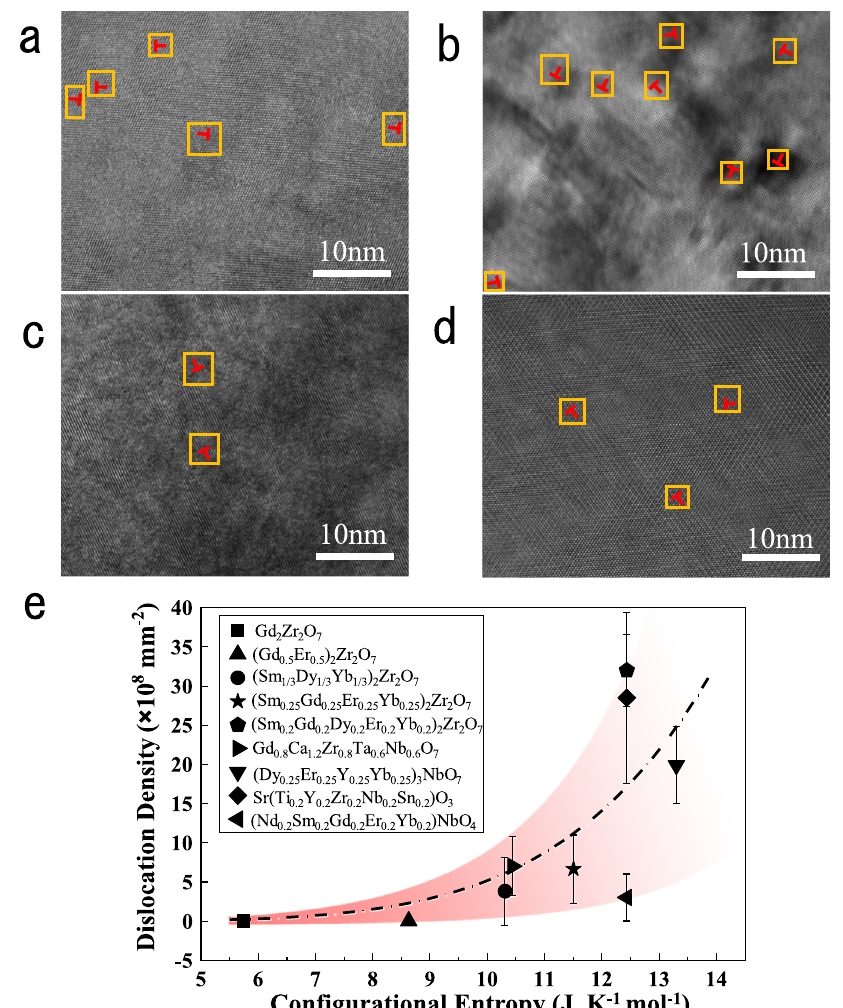
Fig. 4 High-resolution observation of ultra-dense dislocations in high-entropy oxides with various structure. a Fluorite oxides (Dy 0.25 Er 0.25 Y 0.25 Yb 0.25 ) 3 NbO 7 ; b Perovskite oxides Sr(Ti 0.2 Y 0.2 Zr 0.2 Nb 0.2 Sn 0.2 )O 3 ; c fergusonite oxides with monoclinic phase (Nd 0.2 Sm 0.2 Gd 0.2 Er 0.2 Yb 0.2 )NbO 4 ; d Pyrochlore oxides Ca 1.2 Gd 0.8 Zr 0.8 Nb 0.6 Ta 0.6 O 7 ; e Dislocation density varies with con fi gurational entropy. The error bars represent the standard deviation of calculated dislocation density. The yellow squares mark the area around the